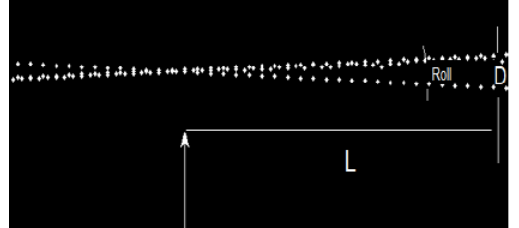
Figure 5. Schematic diagram of the